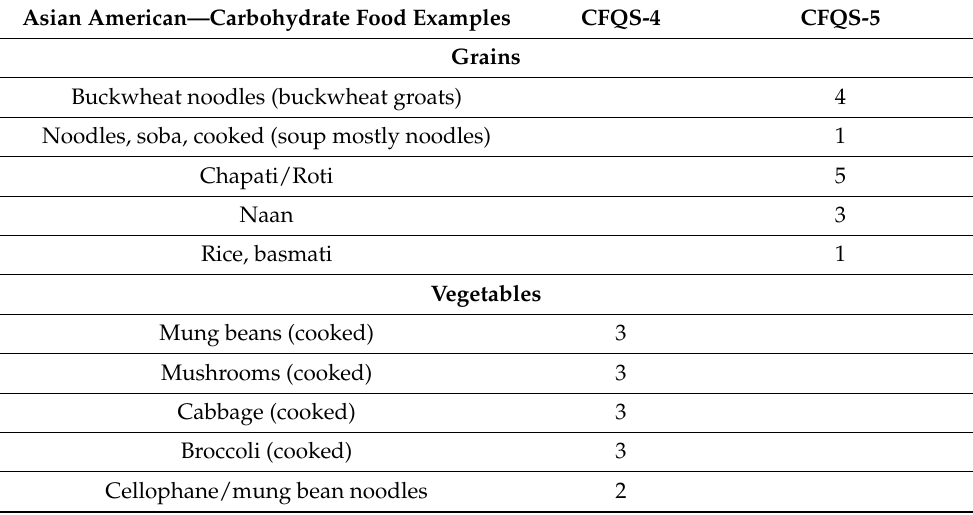
Table 4. CFQS Models Applied to Asian American Culturally Inclusive Dietary Patterns. Asian American—Carbohydrate Food